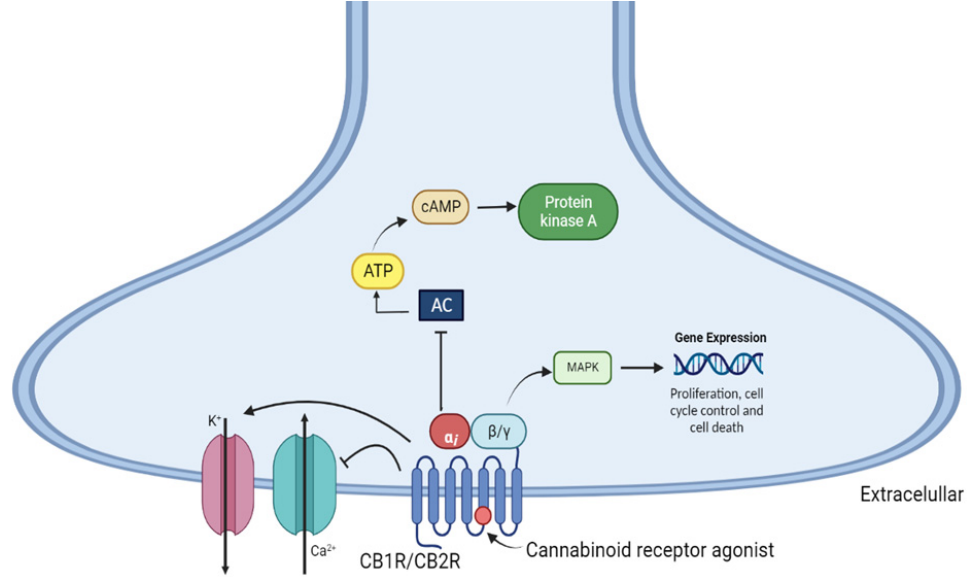
Figure 3. Mechanism of intracellular signaling via activation of CB1 and CB2 cannabinoid receptors. AC—adenylate cyclase, cAMP—cyclic adenosine monophosphate; ATP—adenosine triphosphate; MAPK—mitogen-activated protein kinase; PKA—protein kinase A.